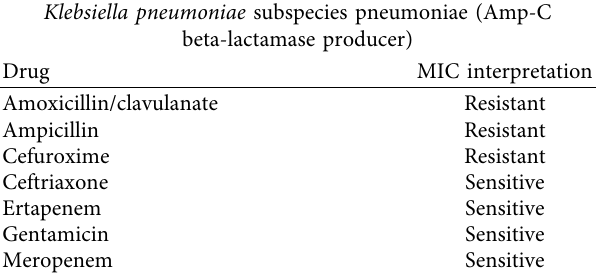
Table 1: Antibiotic susceptibility of Klebsiella pneumoniae sub- species pneumoniae (Amp-C beta-lactamase